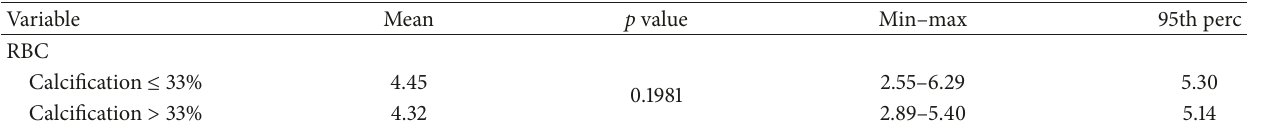
Table 5: t -test for RBC variable.